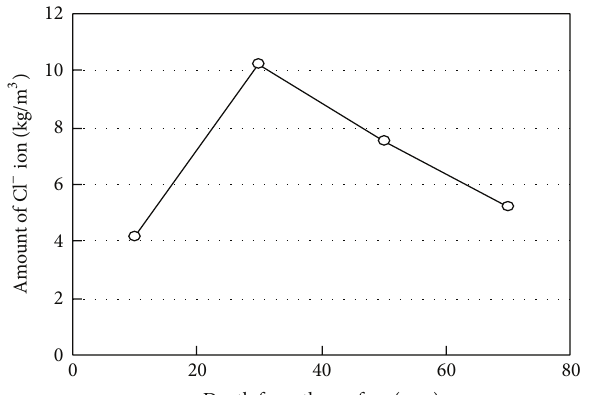
Figure 1: Distribution of chloride ion concentration in the regions near the under surface of RC bridge slabs deteriorated by the penetration of deicing salt.